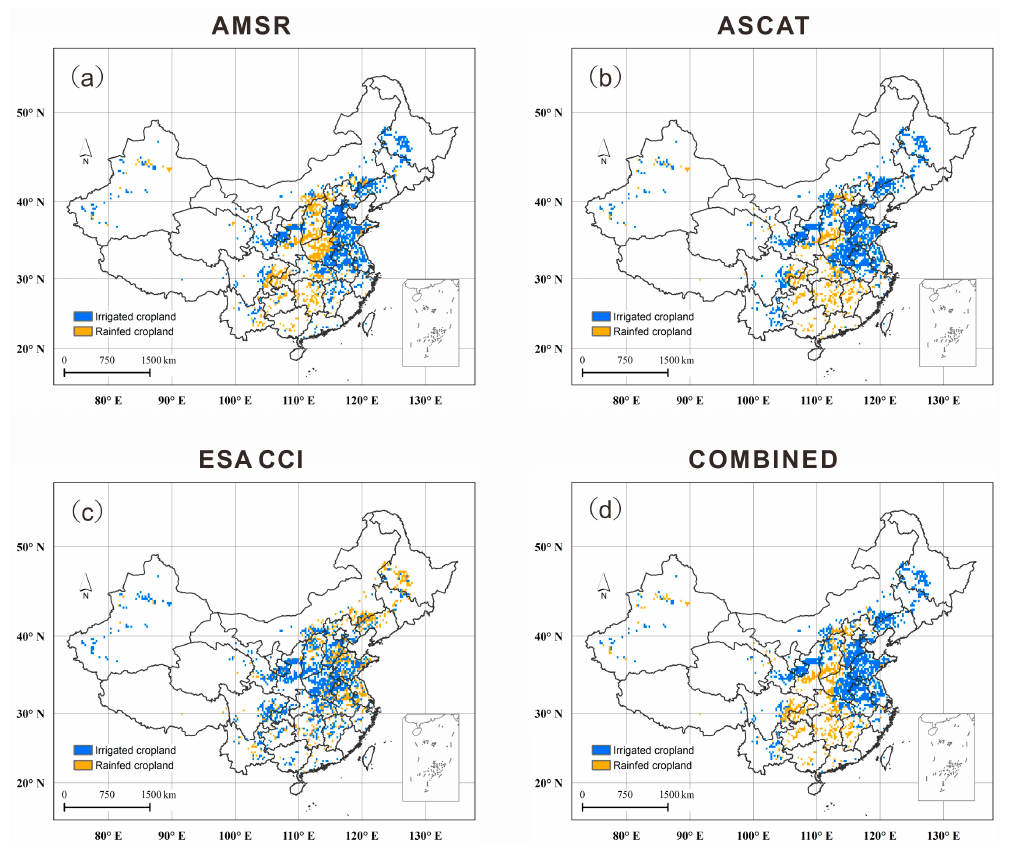
Figure 6. The spatial patterns of discerned irrigated cropland from rain-fed areas by ( a ) AMSR; ( b ) ASCAT; ( c ) ESA CCI; and ( d ) combination of both AMSR and ASCAT.